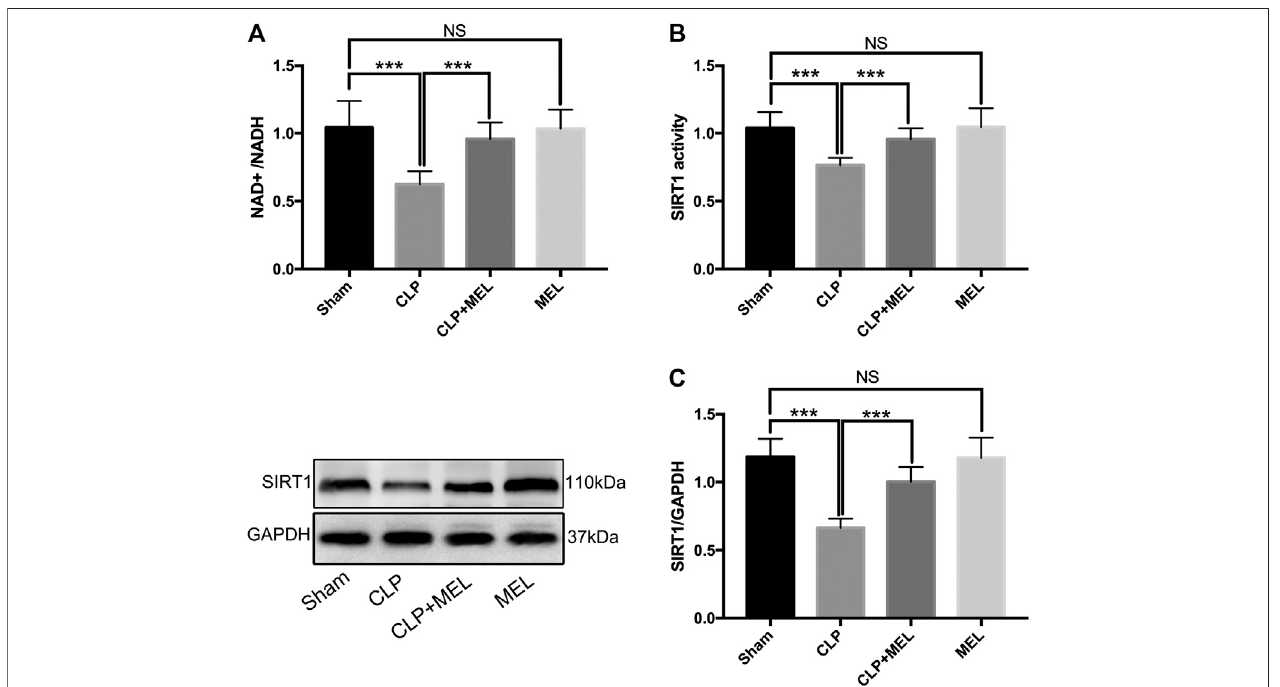
FIGURE 1 | The effect of melatonin on SIRT1. Mice were administrated with melatonin 30 mg/kg daily by intraperitoneal injection for 3 days before CLP or sham operation, on the fourth day mice received one dose of melatonin 1 h before CLP operation. At24 h after CLP surgery, mice were killed and lung tissues were collected. (A) NAD + /NADH and (B) SIRT1 activity were measured by colorimetric assay kit. (C) Protein expression level of SIRT1 was detected by western blot using GAPDH as a loadingcontrol. Results obtained by densitometry ratios oftarget proteinstoGAPDH. All values aremeans ± SD ( n (cid:1) 6 – 8). *** p < 0.001; ** p < 0.01; * p < 0.05 (one- way ANOVA followed by Turkey post hoc